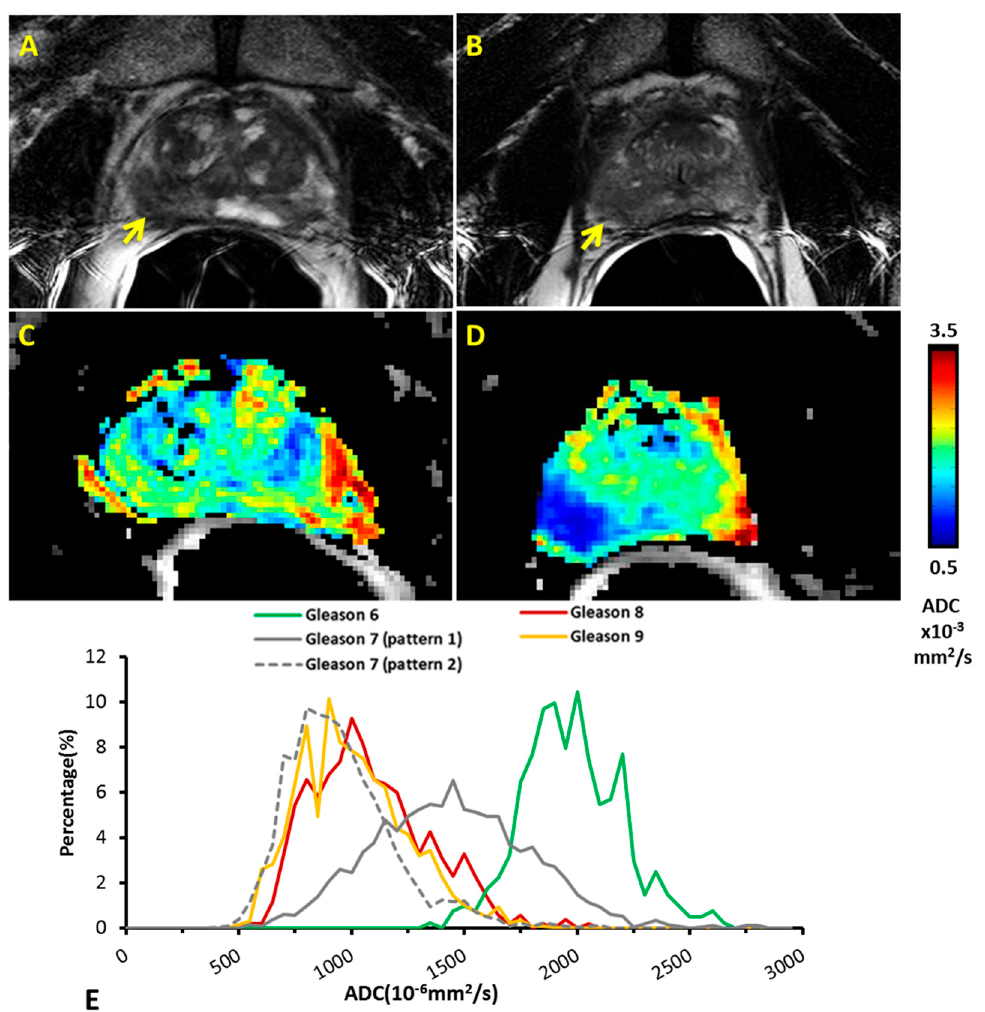
Figure 5. ADC maps and histogram analysis of different Gleason scores. T 2 w images showed hypointense tumor regions (yellow arrows) for both representative patients with Gleason score 6 ( A ) and 8 ( B ). They are the same patients as shown in Figure 2. ADC maps revealed little difference between tumor and normal contralateral prostate for the patient with Gleason score 6 ( C ), but clearly distinguished tumor from normal for the patient with Gleason score 8 ( D ); ( E ) Histograms show mean of ADC distributions for the groups of tumors based on voxel-by-voxel analysis. A clear separation of ADC distribution was found between the high and low Gleason score patients. Two distinct patterns were observed for those patients with intermediate Gleason score. Gleason 6: n = 1; Gleason 8: n = 1; Gleason 9: n = 2; Gleason 7 (pattern 1): n = 3; Gleason 7 (pattern 2): n = 3.